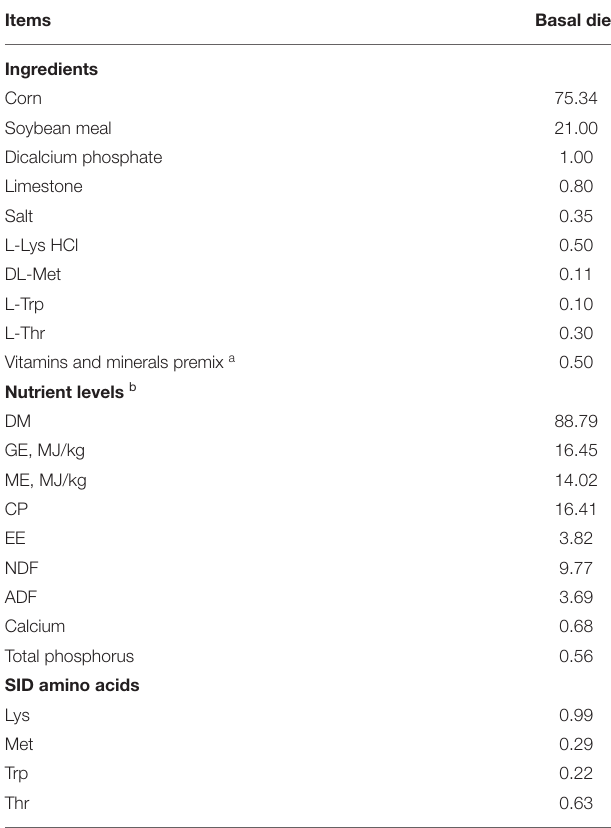
TABLE 1 | Composition and nutrient analysis of the experimental diet (%, as-fed